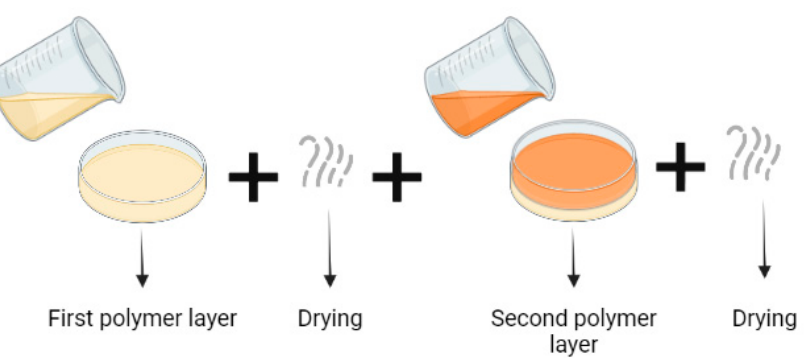
Figure 2. Schematic process of multilayer film formation by the casting method.